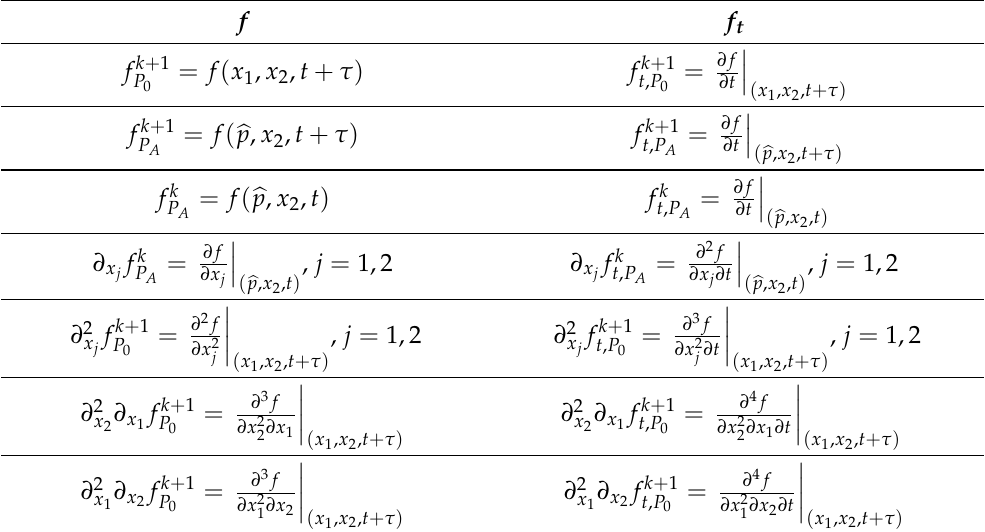
Table 1. Basic notations for the heat source function f and f t